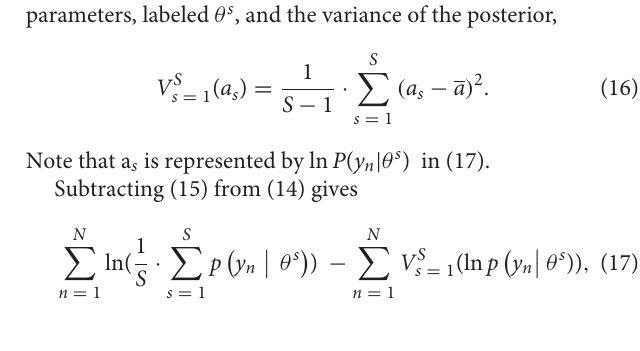
results from the posterior distribution of all model parameters, labeled θ s